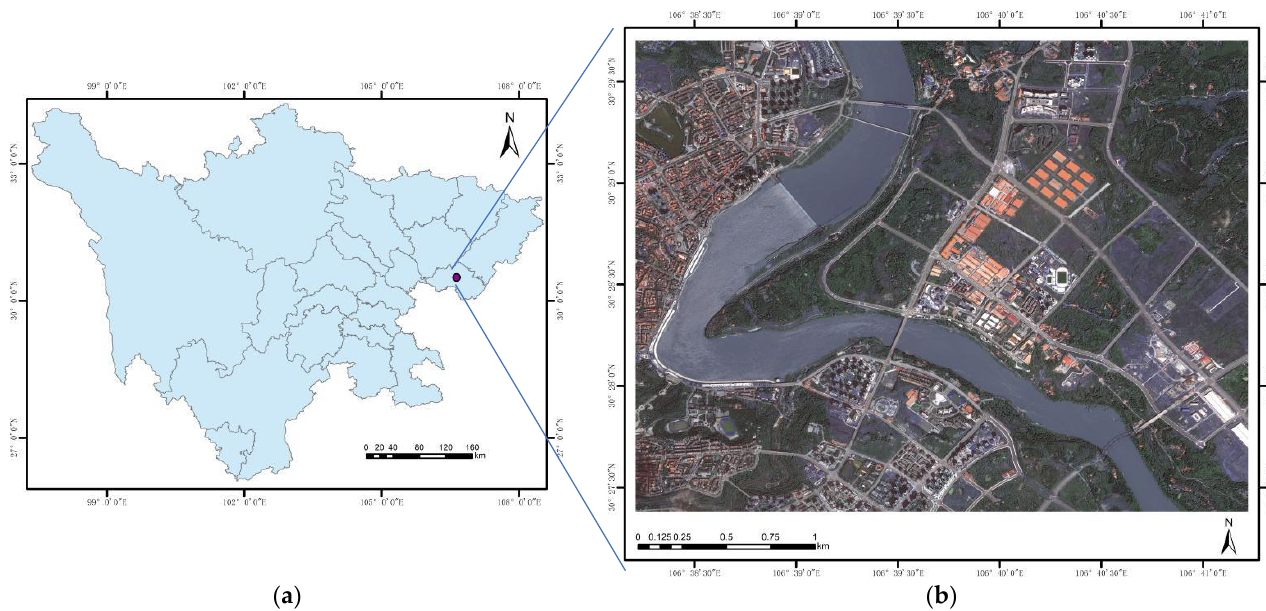
Figure 1. Location and imaging of the study area: ( a ) administrative boundary map of Sichuan Province; ( b ) pre-processed image.